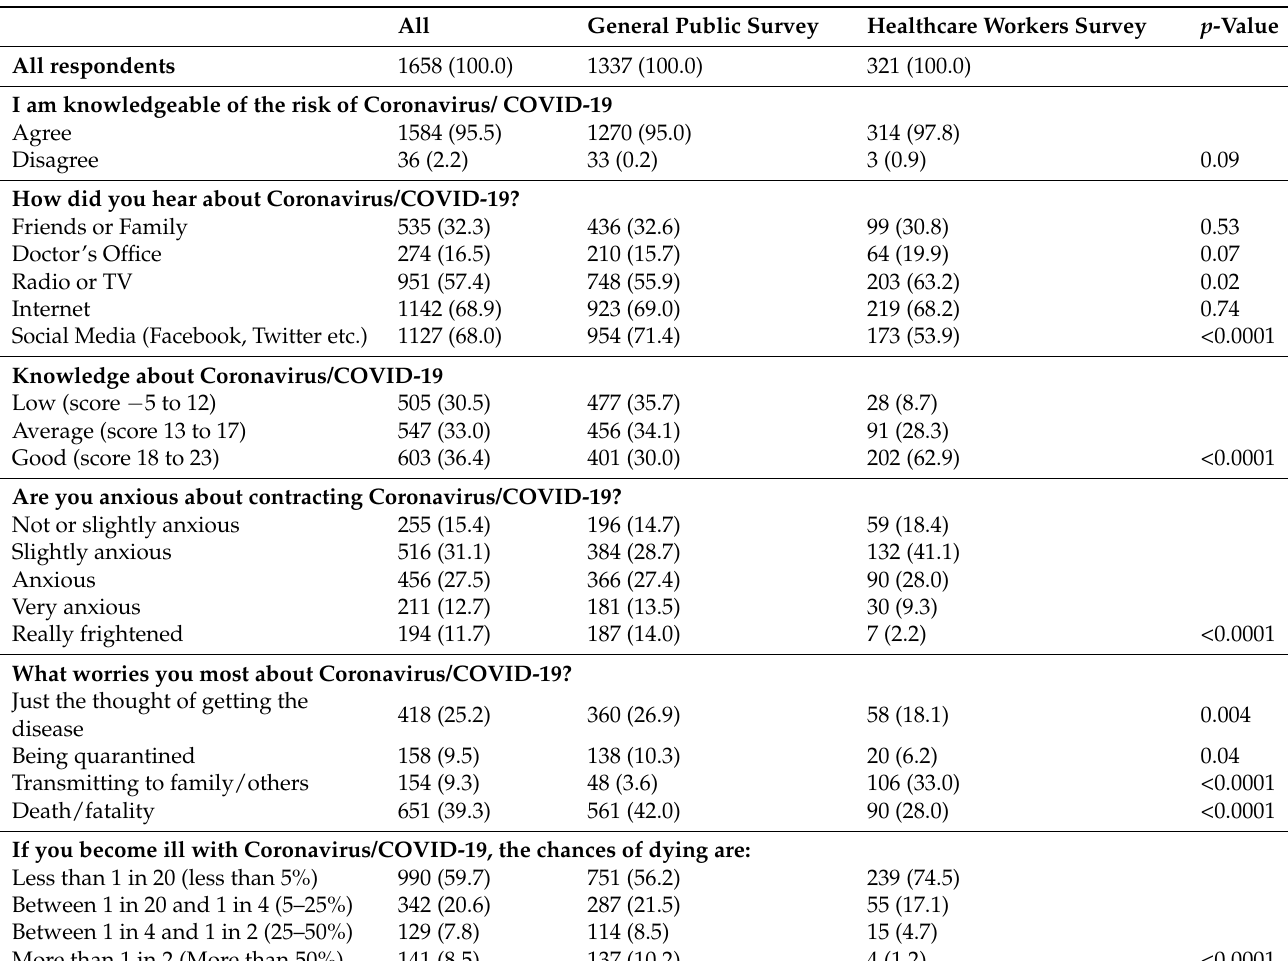
Table 2. Distribution of COVID-19-related responses across